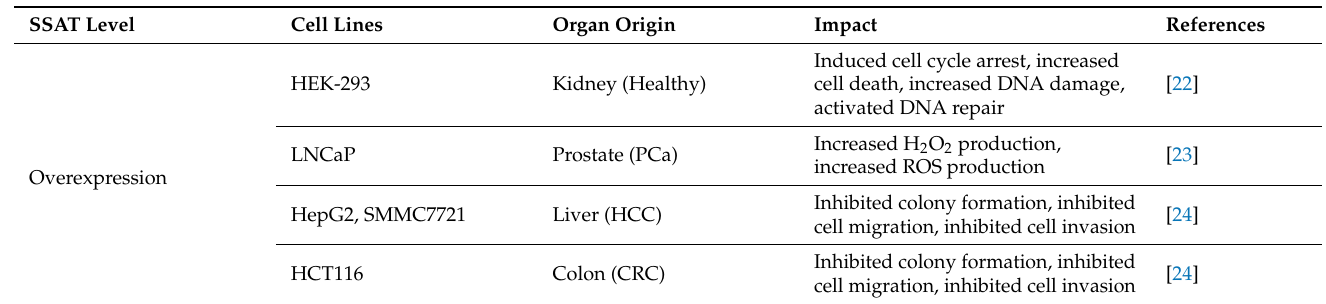
Table 1. Summative table of different in vitro studies on cellular impacts induced by different SSAT